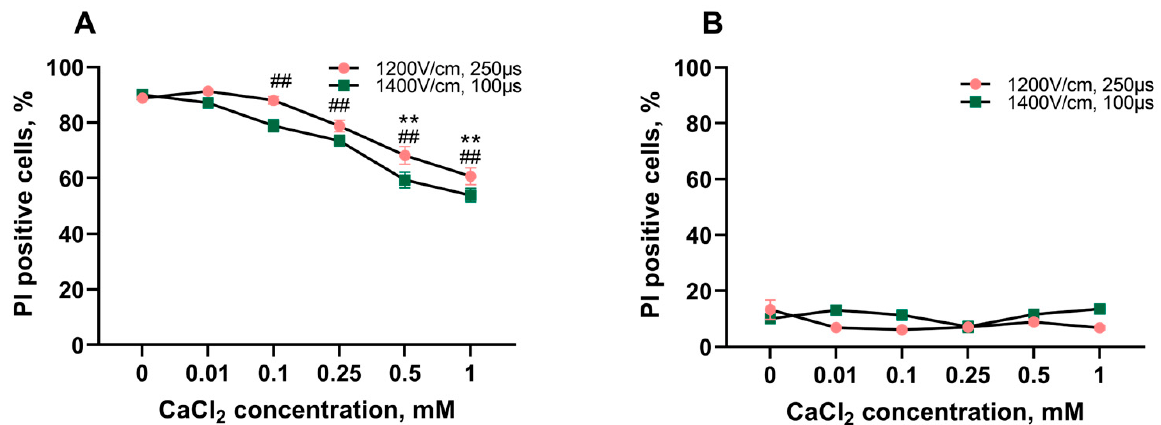
Figure 5. The dependence of PI electrotransfer efficiency on the strength of the applied electric field at different CaCl 2 concentrations either before ( A ) or after ( B ) electroporation. Cells were treated using one square pulse of 1200 V/cm for 250 µ s or 1400 V/cm for 100 µ s. Error bars represent the standard error of the mean (SEM) of n = 9 experimental replicates. In case standard errors were lower than actual data points, error bars are not visible. The statistical significance between the control (0 mM) and the 0.1, 0.01, 0.25, 0.5, and 1 mM CaCl 2 concentrations are denoted by ** (1200 V/cm) and ## (1400 V/cm). ** and ## represents the p < 0.01.